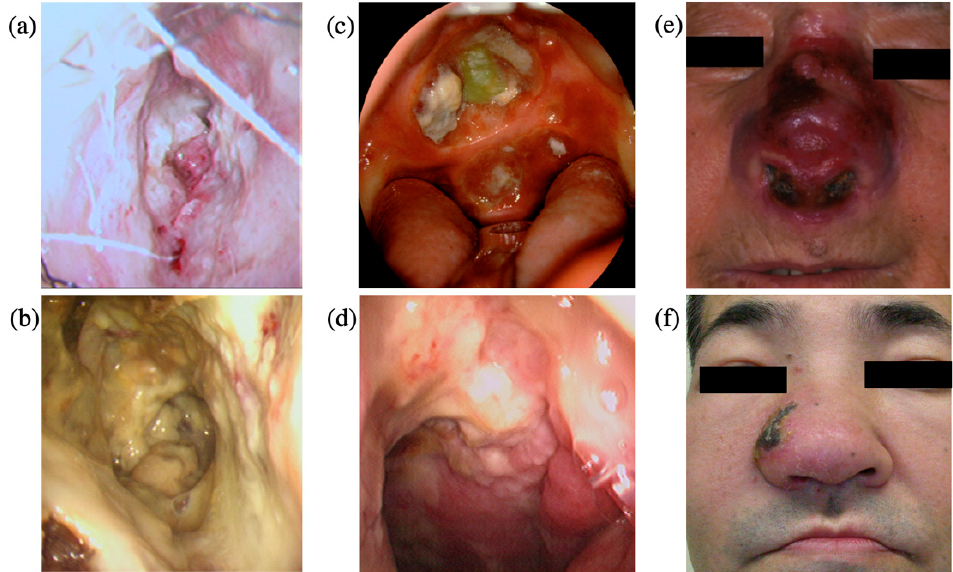
Figure 1. The representative local findings of extranodal NK/T-cell lymphoma, nasal type. ( a ) Granulation in the nasal cavity; ( b ) necrotic tissue in the nasal cavity; ( c ) ulceration of the hard palate; ( d ) necrotic granulation in the nasopharynx; ( e , f ) infiltration of the nasal skin. The most frequent symptoms are nasal obstruction and bloody nasal discharge